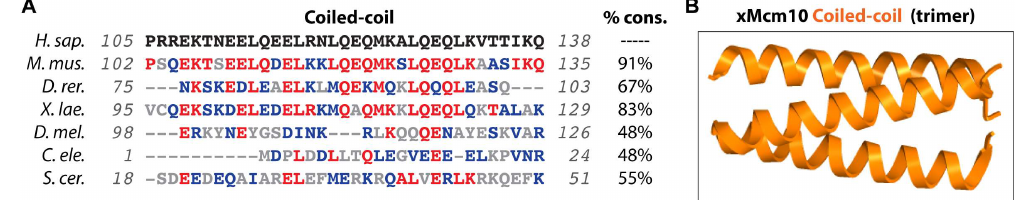
Figure 3. Evolutionary conservation of functional domains in the Mcm10 NTD. ( A ) Comparison of the amino acid sequences from H. sapiens , M. musculus , D. rerio , X. laevis , D. melanogaster , C. elegans , S. pombe and S. cerevisiae of the coiled-coil domain. The percent conservation (% cons.), defined as the percentage of amino acid positions identical (in red) or strongly similar (in blue) to those of human Mcm10, is listed for each domain sequence. The total region aligned for each sequence listed in gray. ( B ) The crystal structure of the Xenopus Mcm10 (xMcm10) coiled-coil domain is shown. The structure was generated using pdb data file 4JBZ and the Chimera program (http://www.cgl.ucsf.edu/chimera) [83].